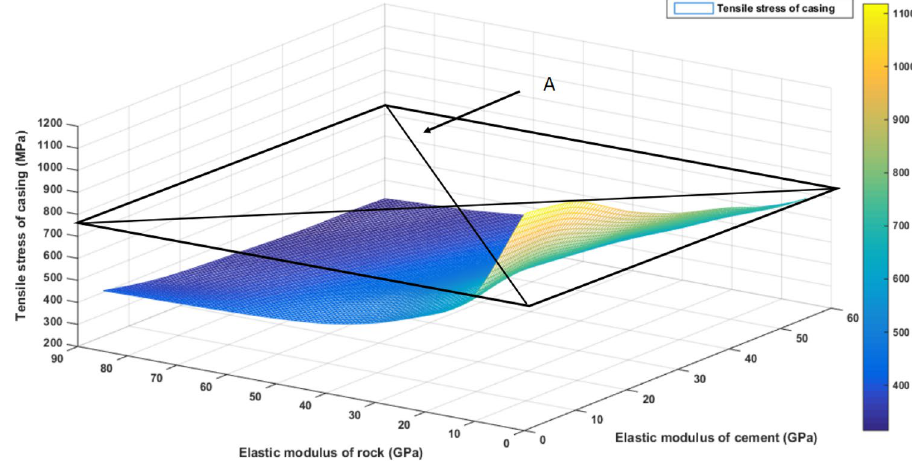
Fig. 17 Three-dimensional variation curve of casing tensile stress versus Young’s modulus of elasticity of rock-coupled